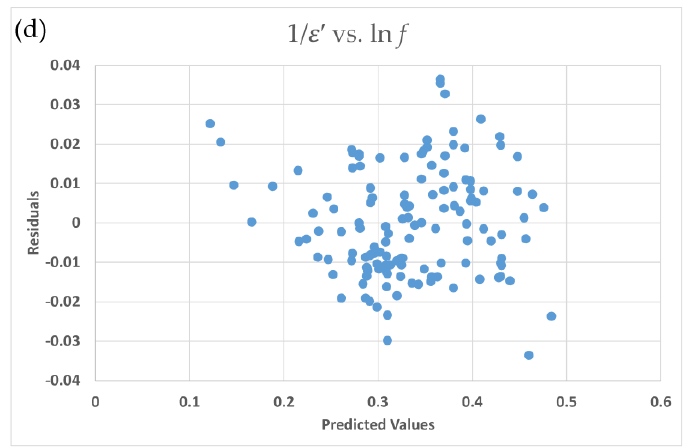
Figure 2. Residual plots for the dielectric constant ε’ equation for egg white power (Boreddy